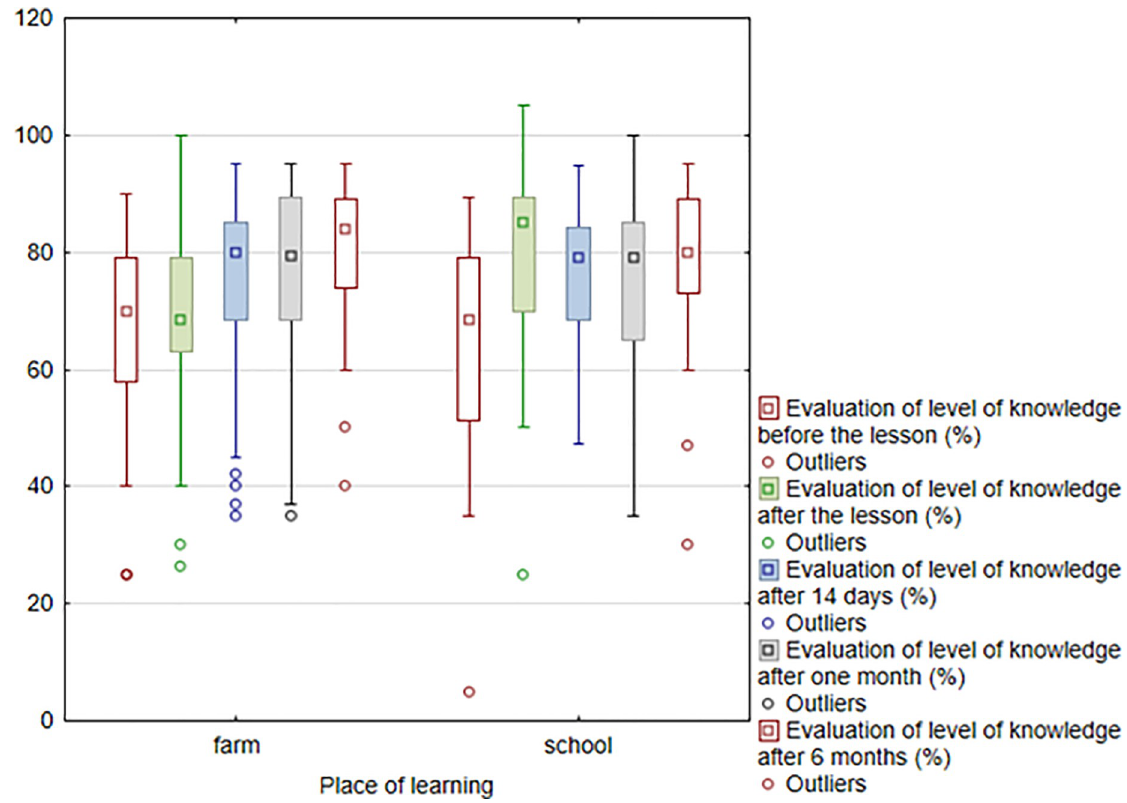
Fig 1. Evaluation of the level of knowledge before, immediately after the lesson, 14 days, one month, and six months after the lesson on the farm and in school (%).